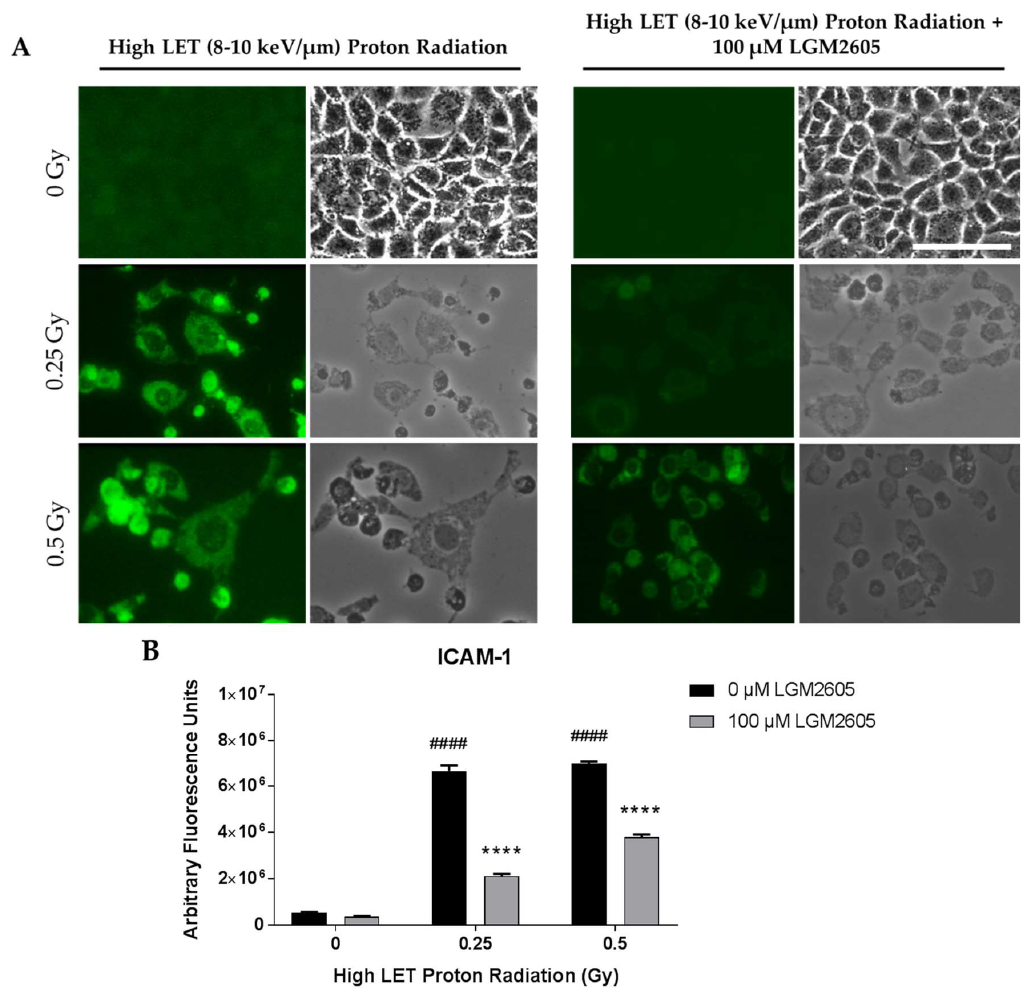
Figure 7. Evaluation of LGM2605 inhibition of ICAM-1 expression in in vitro lung vascular networks (flow-adapted endothelial cells) exposed to high LET proton radiation. FAECs were exposed to 0 Gy, 0.25 Gy, or 0.5 Gy high LET (8–10 keV/ µ m) proton radiation and treated with 0 µ M or 100 µ M LGM2605 30 min following radiation exposure. Cells were harvested 24 h post radiation exposure and evaluated for ICAM-1 expression. Fluorescent images of FAECs exposed to LGM2605 (0 µ M or 100 µ M) 30 min following radiation exposure and harvested at 24 h radiation exposure and incubated with anti-ICAM-1 antibody (ThermoFisher Scientific, Waltham, MA, USA). Scale bar = 20 µ m ( A ); graphed representation of the data imaged for each condition ( B ). Data are presented as mean ± SEM. # shown in figures with 0 µ M LGM2605 (#### p < 0.0001). Asterisks shown in figures indicate significant differences